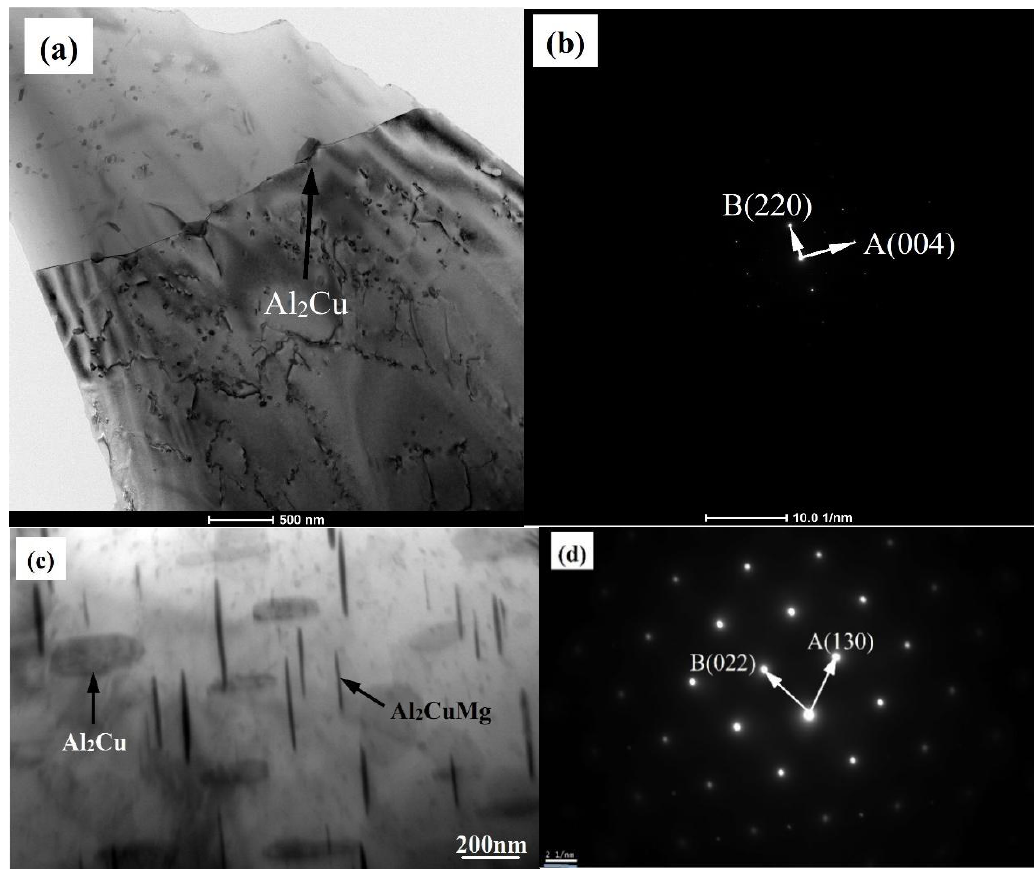
Figure 15. TEM microstructure and selected area electron diffraction (SAED) of rheoformed 2024 aluminum matrix composite component reinforced by 5 vol % Al 2 O 3 nanoparticles for 25 min stirring time at 615 °C and 625 °C ( a ) TEM image at 615 °C ( b ) SAED at 615 °C ( c ) T EM image at 625 °C ( d ) SAED at 625 °C.